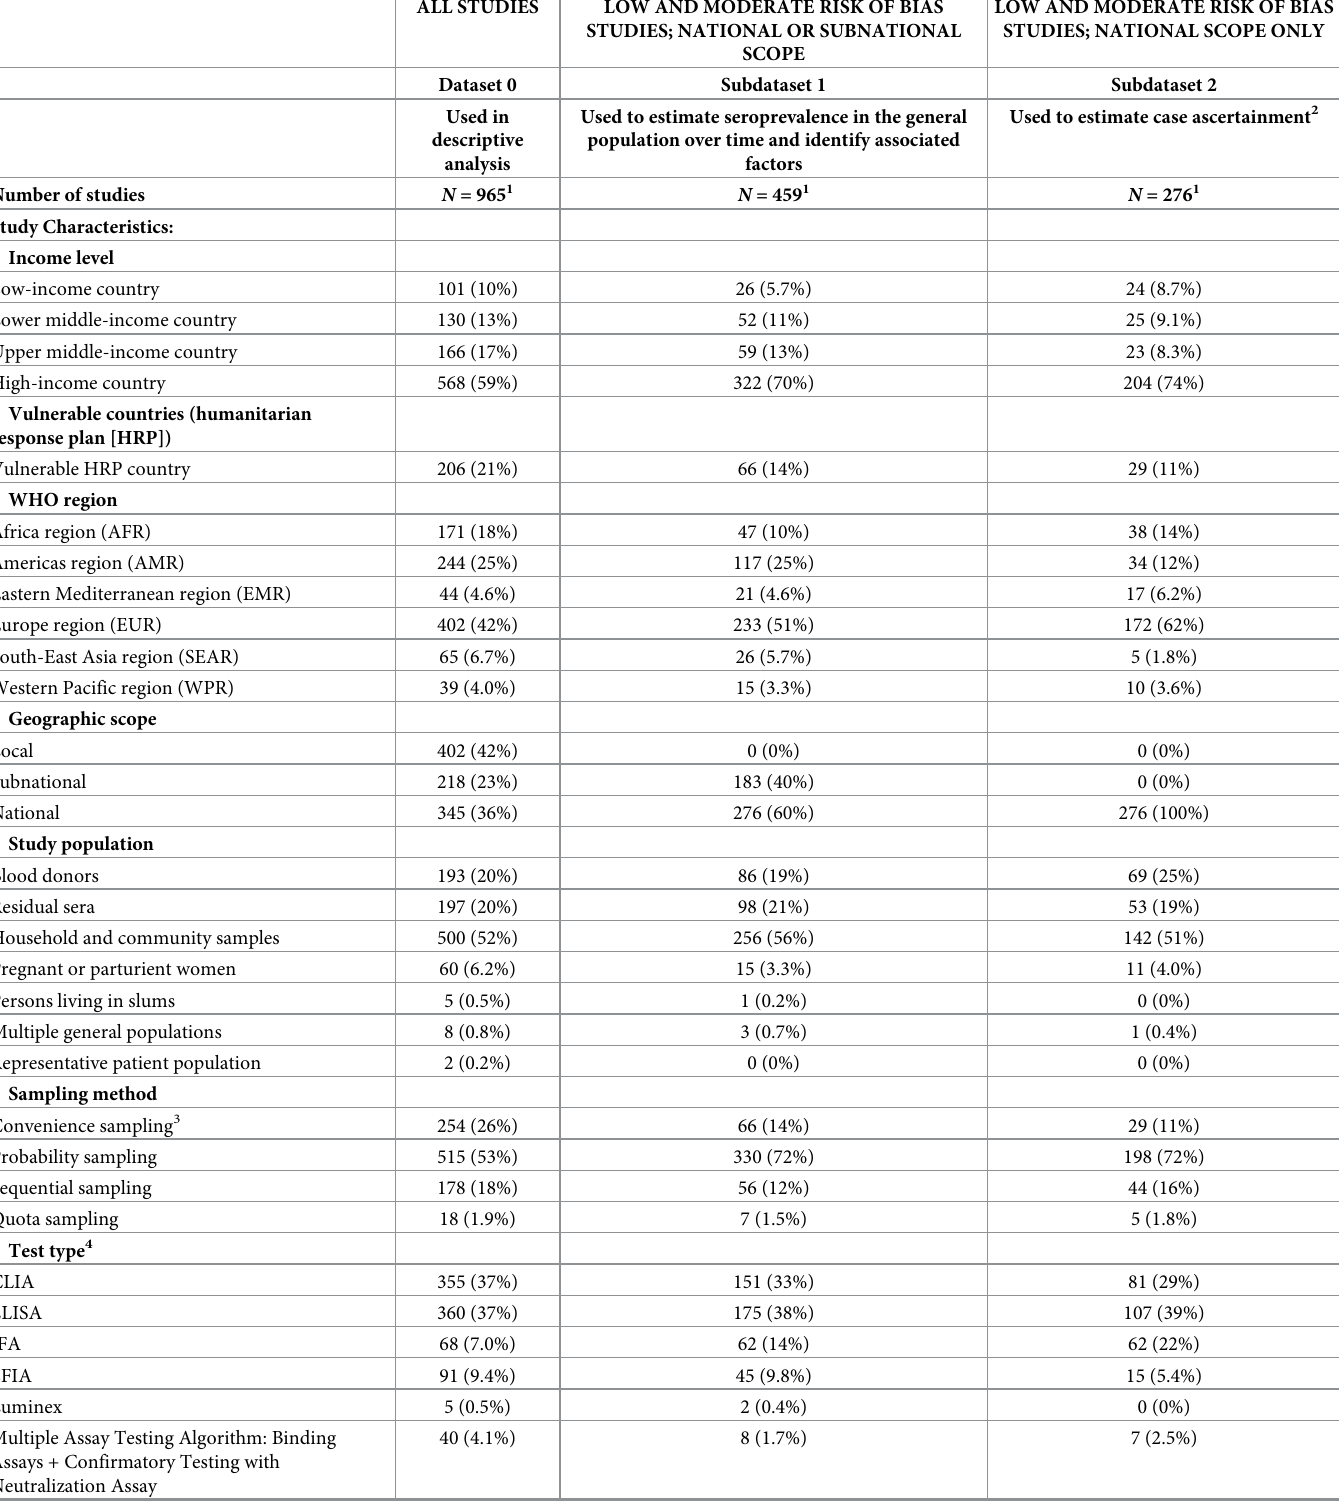
Table 1. Characteristics of included studies, January 2021–May